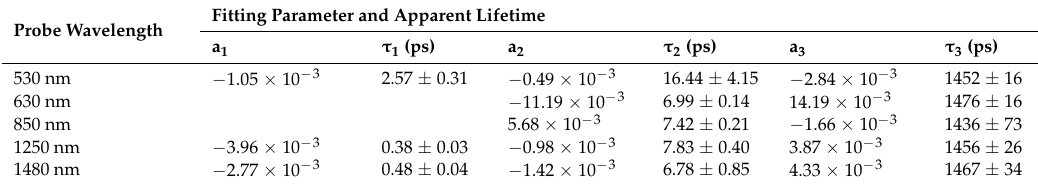
Table 1. Decay time constants ( τ ) derived from multi-exponential curve fitting of the kinetics for